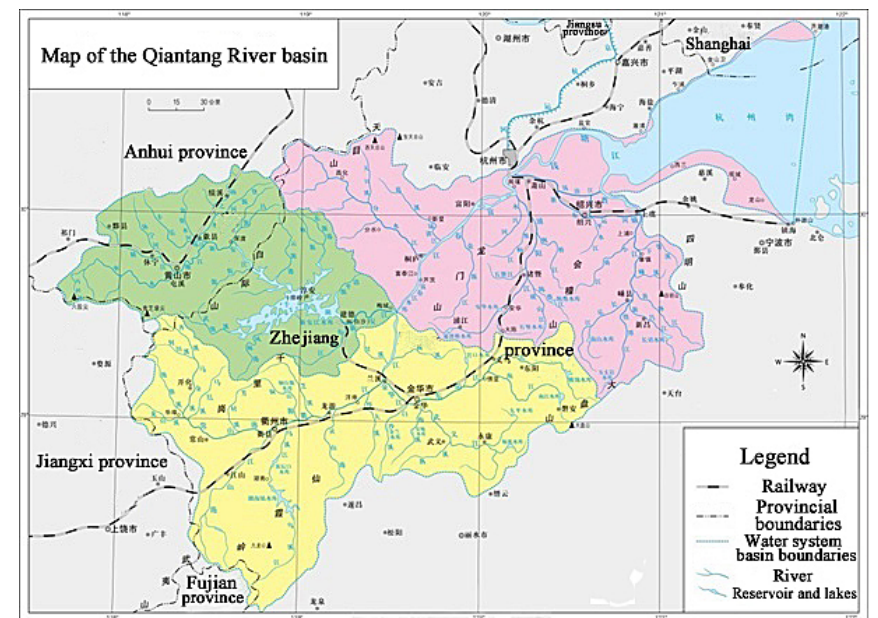
Figure 1. Map of the Qiantang River basin (three colors in the map refer to three trunk regions of the Qiantang River: green is the trunk region of Xinan River, yellow refers to the Lan River region, pink refers to the Fuchun River and Qiantang River